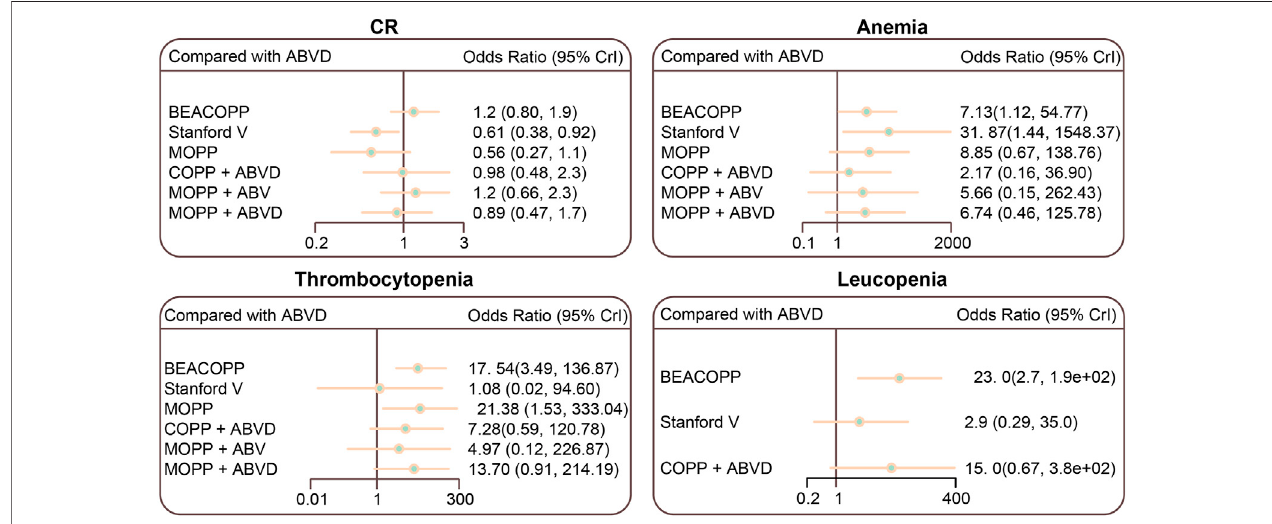
FIGURE 5 | Relative relationship forest plots for CR, anemia, thrombocytopenia, and leucopenia in advanced HL patients treated with different chemotherapy regimens. ABVD (doxorubicin + bleomycin + vinblastine + dacarbazine); BEACOPP (bleomycin + etoposide + doxorubicin + cyclophosphamide + vincristine + procarbazine + prednisone); Stanford V (doxorubicin + vinblastine + mechlorethamine + vincristine + bleomycin + etoposide + prednisone); MOPP (mechlorethamine + vincristine + procarbazine + prednisone); COPP (cyclophosphamide + vincristine + procarbazine + prednisone); ABV (Hybrid) (doxorubicin + bleomycin +